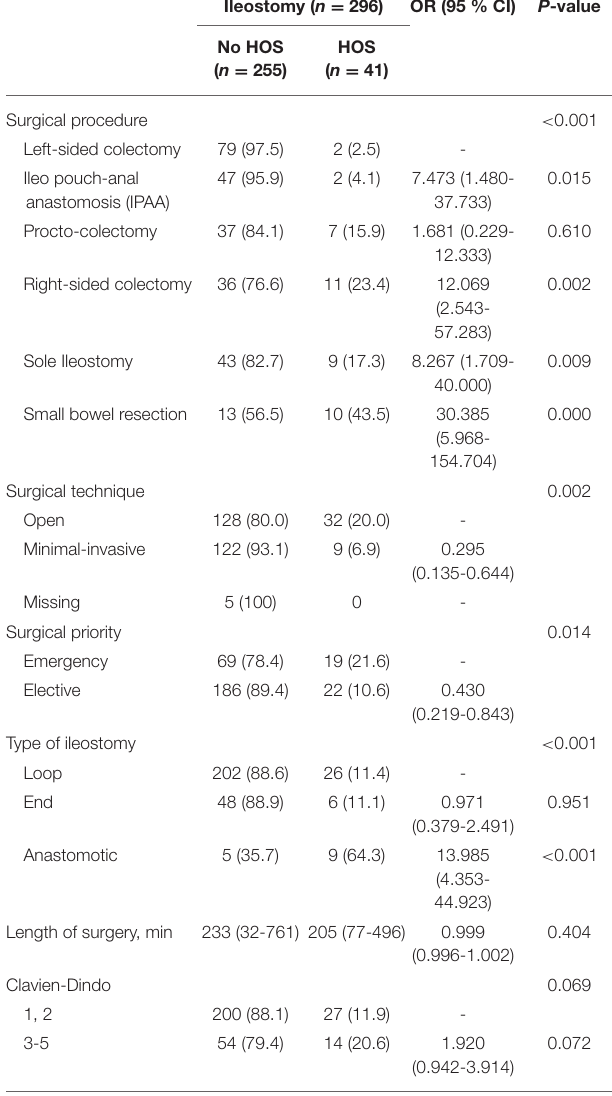
TABLE 3 | Operation specific risk factors for HOS. TABLE 4 | Multivariable logistic regression of risk factors for the development of